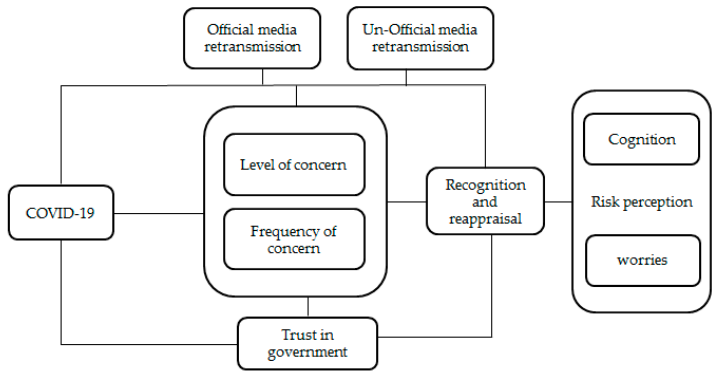
Figure 1. The new framework of risk perception of COVID-19.